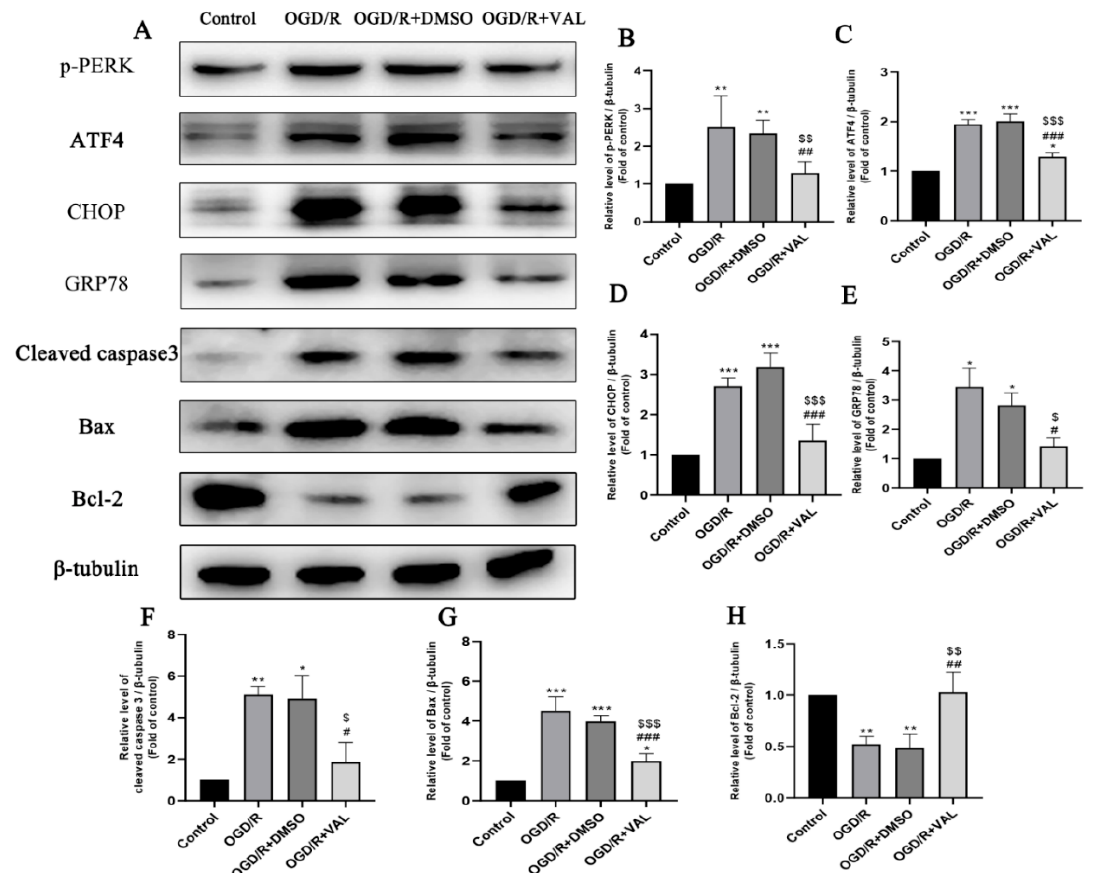
Figure 3. Effect of valdecoxib on the expression of ER stress-related and apoptosis-related proteins in the OGD/R model. ( A ) Western blot analysis of p-PERK, ATF4, GRP78, CHOP, cleaved caspase 3, bax and bcl-2 levels in the control, OGD/R, OGD/R+DMSO and OGD/R+VAL groups. ( B – H ) Quantification of expression levels of p-PERK, ATF4, GRP78, CHOP, cleaved caspase 3, bax and bcl-2 in the control, OGD/R, OGD/R+DMSO and OGD/R+VAL groups using the densitometric analyses of Western blotting. The bar charts show the quantitative data (normalized by β -tubulin) for each protein relative to the control group (assigned a value of 1). Data are represented as the mean ± SD of three independent experiments. One-way ANOVA is used in B to H. * p < 0.05, ** p < 0.01, *** p < 0.001 vs. control group. # p < 0.05, ## p < 0.01, ### p < 0.001 vs. OGD/R group. $ p < 0.05, $$ p < 0.01, $$$ p < 0.001 vs. OGD/R+DMSO group.